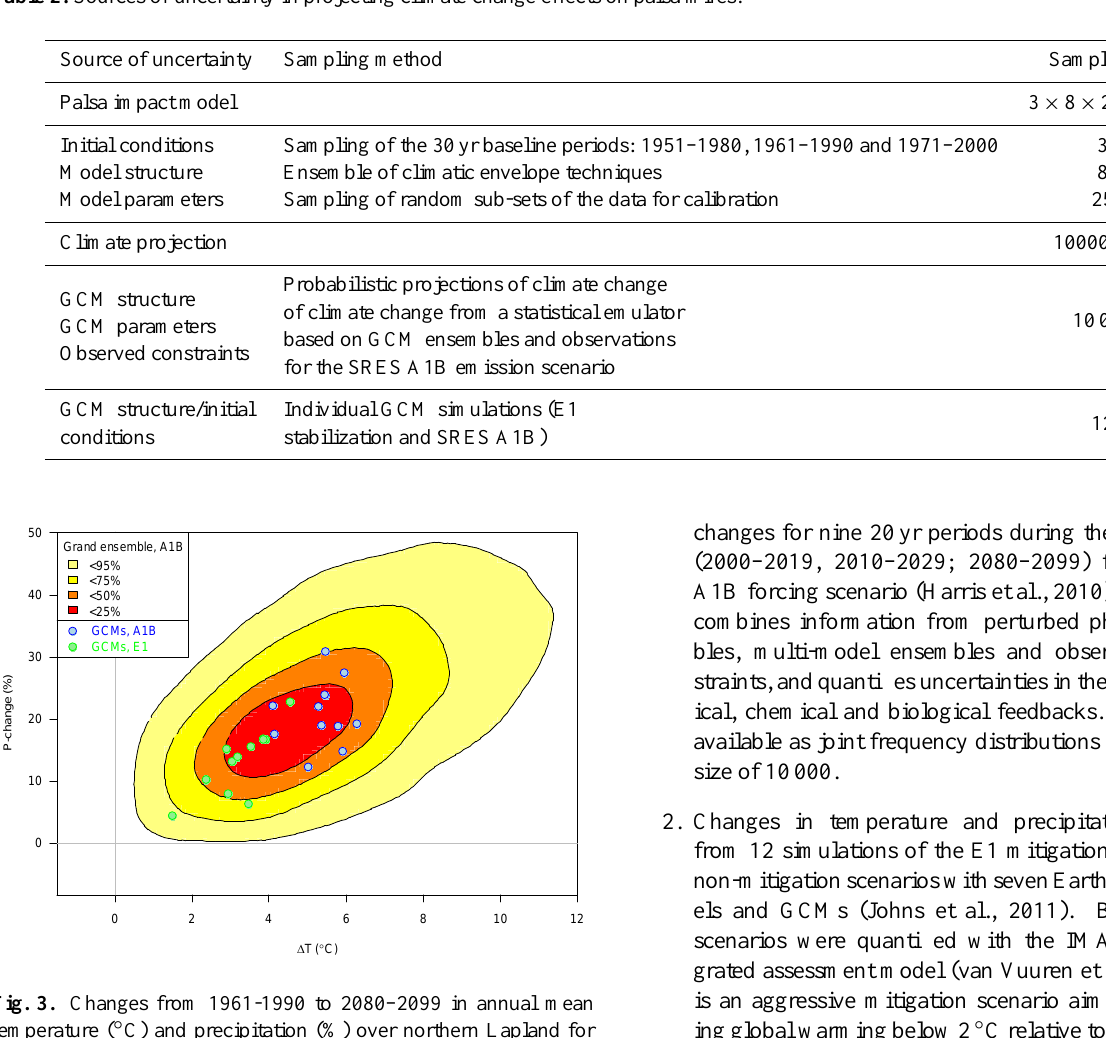
Table 2. Sources of uncertainty in projecting climate change effects on palsa mires.